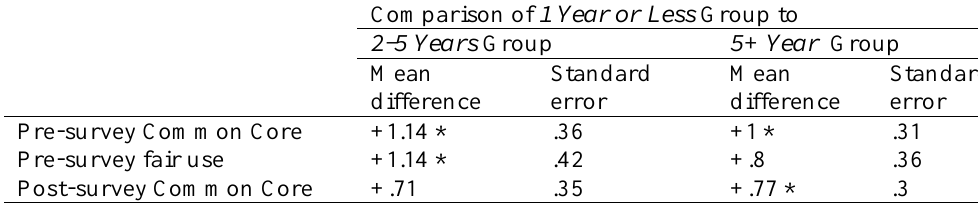
Main Effect Comparison of Less and More Experienced Teachers on Knowledge Items